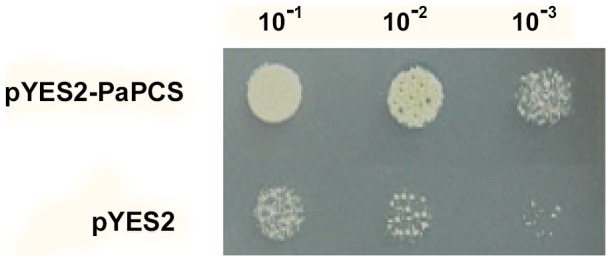
Functional testing of PaPCS in the Cd sensitive yeast strain YK44.Yeast cells harboring either an empty pYES2 vector or pYES2-PaPCS were cultured and inoculated into 40 µL YPGAL medium in 10−1, 10−2, and 10−3 concentrations in the presence of 100 µM CdCl2. After 48 h, the growth of transgenic cells heterologously expressing PaPCS was compared to control cells carrying an empty pYES2 vector. All experiments were done in quadruplicate.